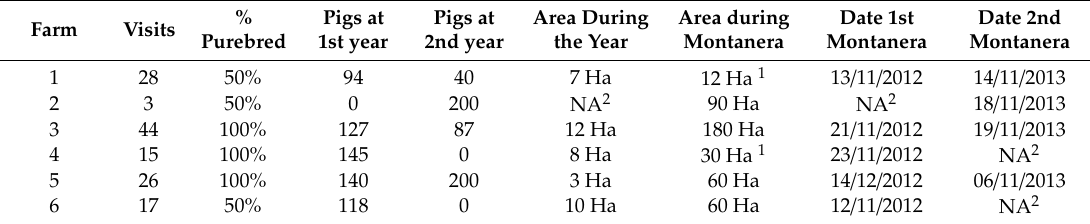
Table 1. Number of visits to each farm, percentage of purebred, quantity of pigs in the first and second year, available area during the year and during montanera, dates of montanera start for the first and second year of